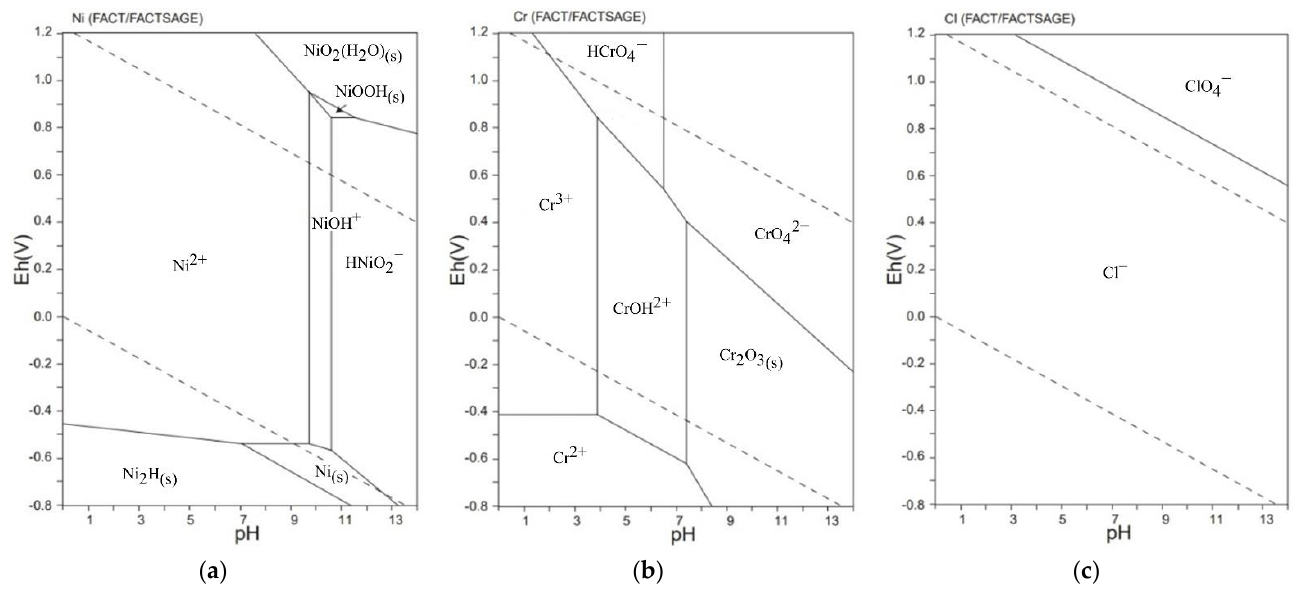
Figure 6. The Eh-pH diagrams of ( a ) nickel, ( b ) chromium, and ( c ) chlorine. Table 6. The recovery rates of metals from stainless steel waste by different recycling technologies.